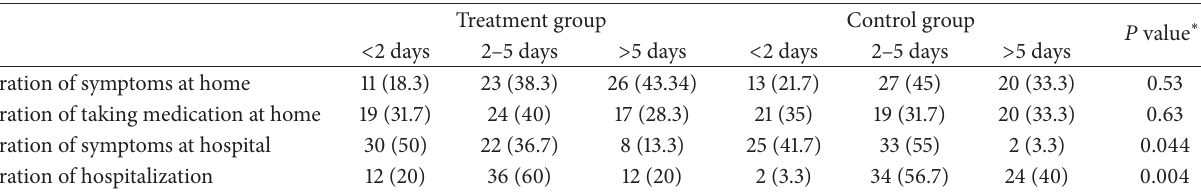
↑ Both groups included 60 members. The corresponding values in the table are number (percentage). ∗ Chi-square: 𝛼 = 0.05